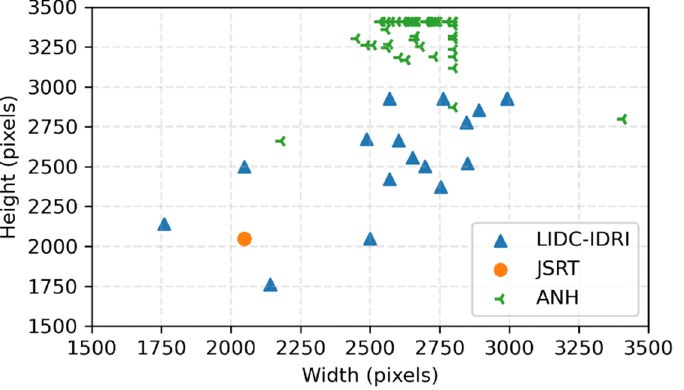
Figure 1. Resolution distribution of all images.